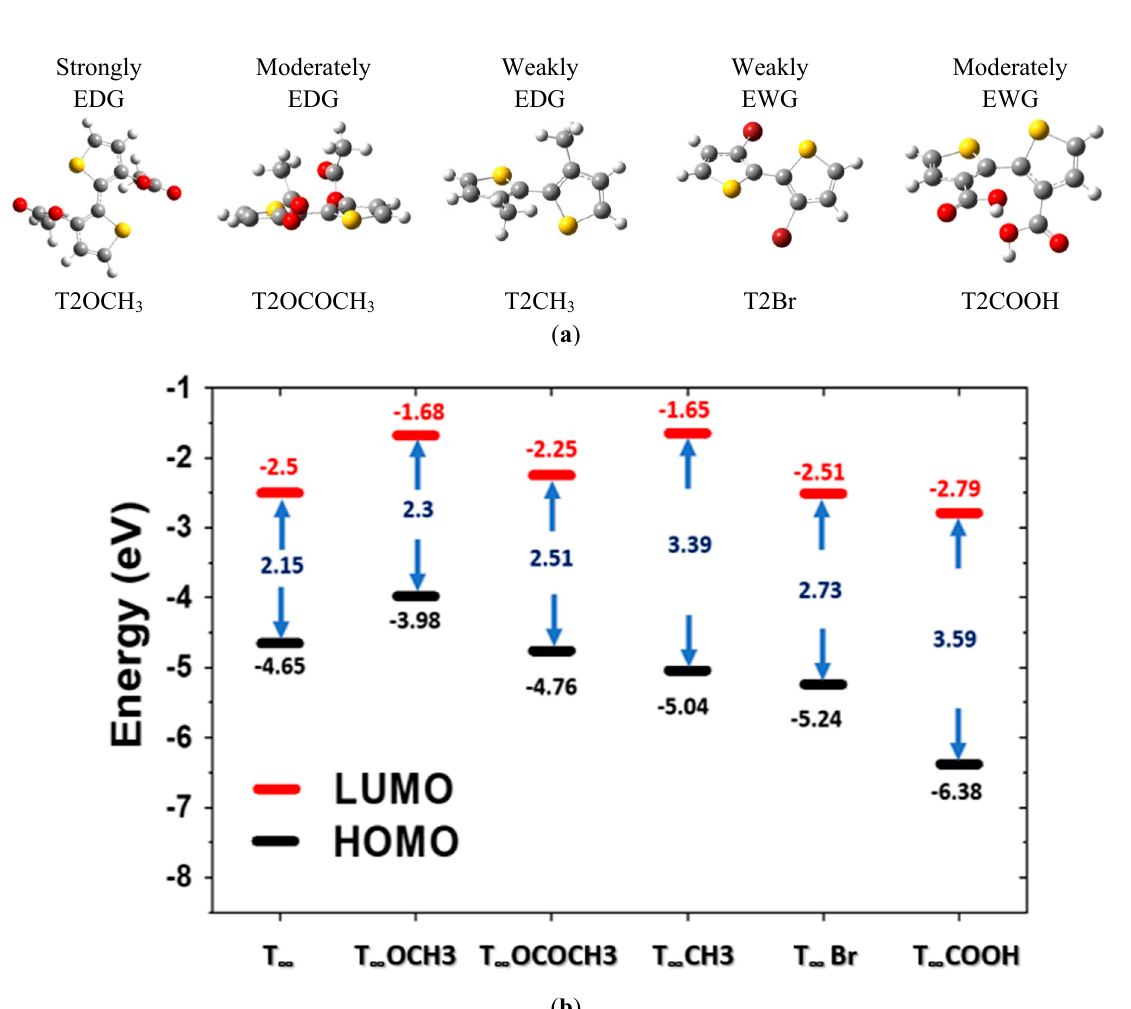
Figure 7. ( a ) Molecular structure of PT derivatives studied in this work. EDG and EWG denote electron-donating groups and electron-withdrawing groups, respectively; ( b ) Calculated energy levels of HOMO and LUMO of PT derivatives.